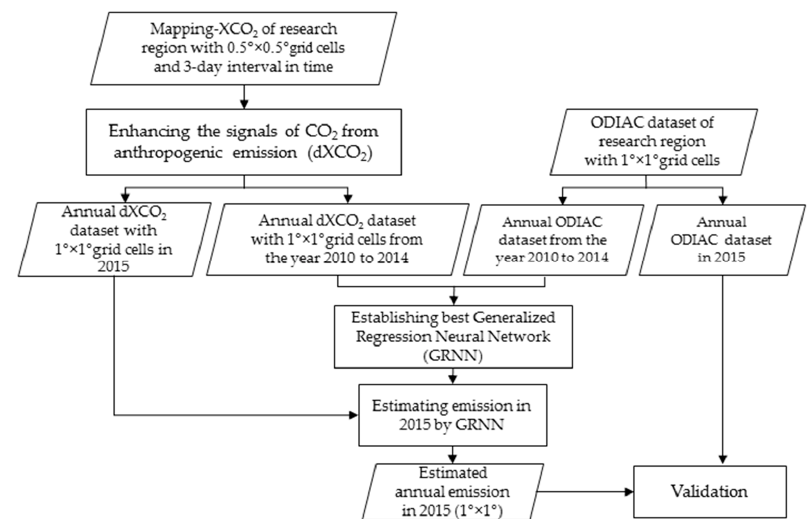
Figure 2. Flowchart of estimating anthropogenic emission using XCO 2 data obtained by